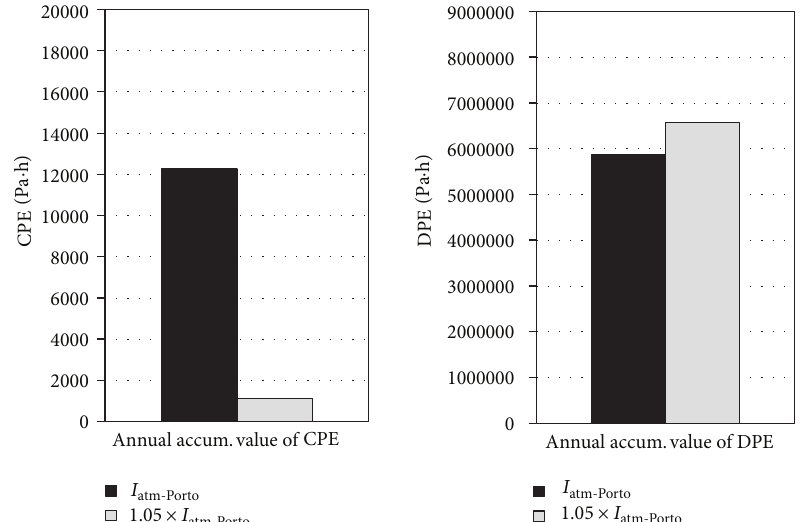
Figure 19: Exterior climate: atmospheric radiation.